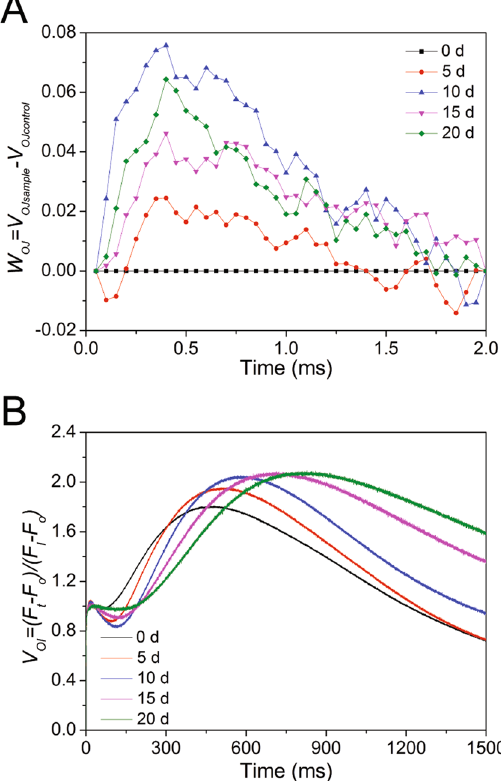
Figure 5. Fluorescence kinetics from the OJIP transients of nitrogen-starved P. cruentum . ( A ) kinetic differences in V OJ obtained after double normalization between the steps O-J, showing the K-band at approximately 300 μ s. ( B ) O-I normalized fluorescence